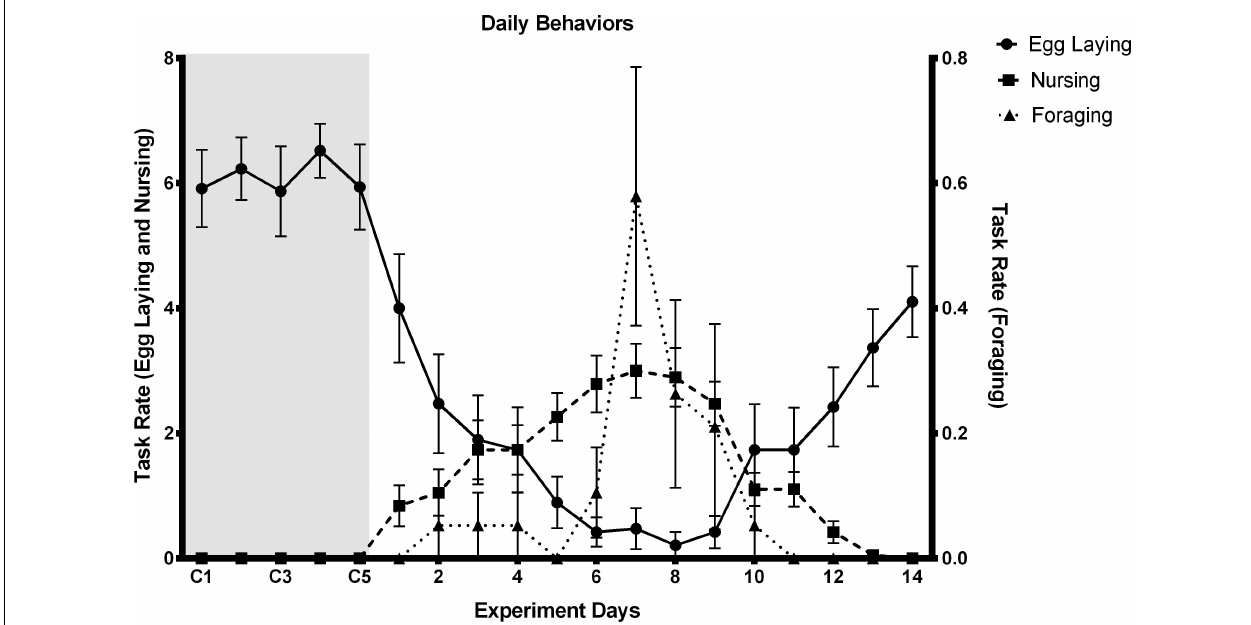
FIGURE 2 | Daily behavior rate. Task frequency of Queens ( n = 19) during the experiment. The shaded area represents tasks during the control period (5 days). Workers were removed on day 5 after final control observations (C5). Egg laying behavior decreased significantly at day 4; Chi-square = 118.524, df = 18, p -value ≤ 0.001, just as nursing behavior increased significantly; Chi-square = 14.58, df = 18, p -value ≤ 0.001, foraging increased significantly, at day 7; Chi-square = 37.71, df = 18, p -value ≤ 0.001. On day 12 the population began to grow as workers emerged. At day 13 queens increased egg laying and decreased nursing, completing a cycle. First 3 days show no significant difference with the last 3 days; Dunn p -value ≥ 0.05. Behaviors were observed tabulated as number of events occurred during the observation period.